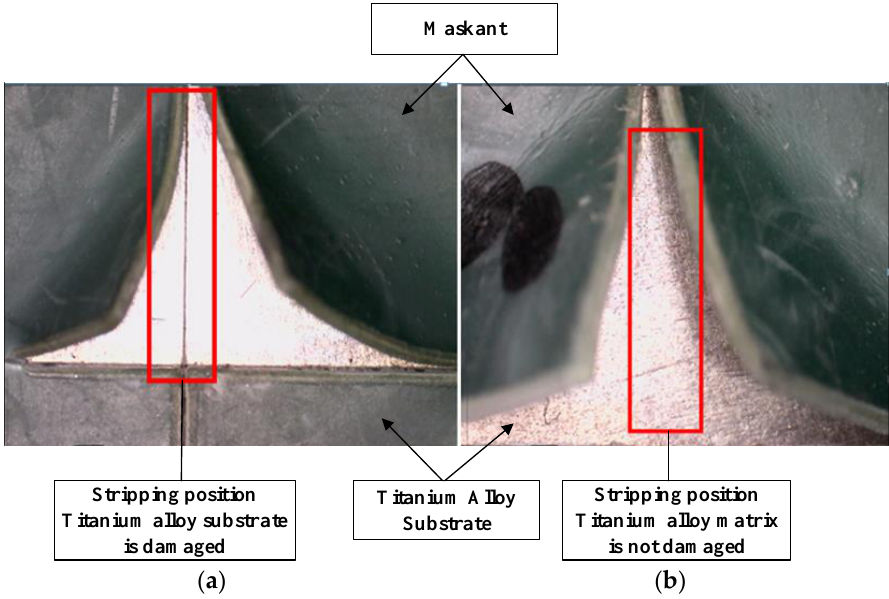
Figure 7. Ablation of the substrate in laser scribing. ( a ) The titanium alloy substrate is damaged. ( b ) The titanium alloy substrate is not damaged.